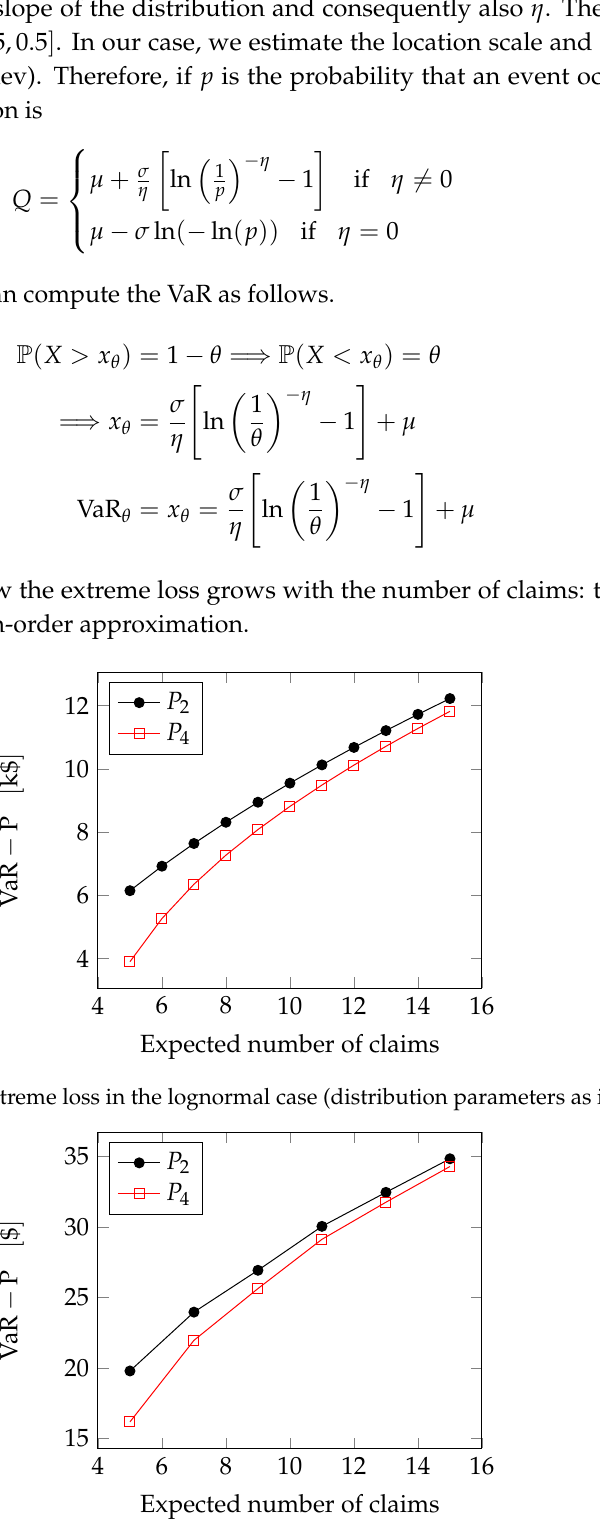
Figure 7. Insurer’s extreme loss in the Pareto case (distribution parameters as in Table